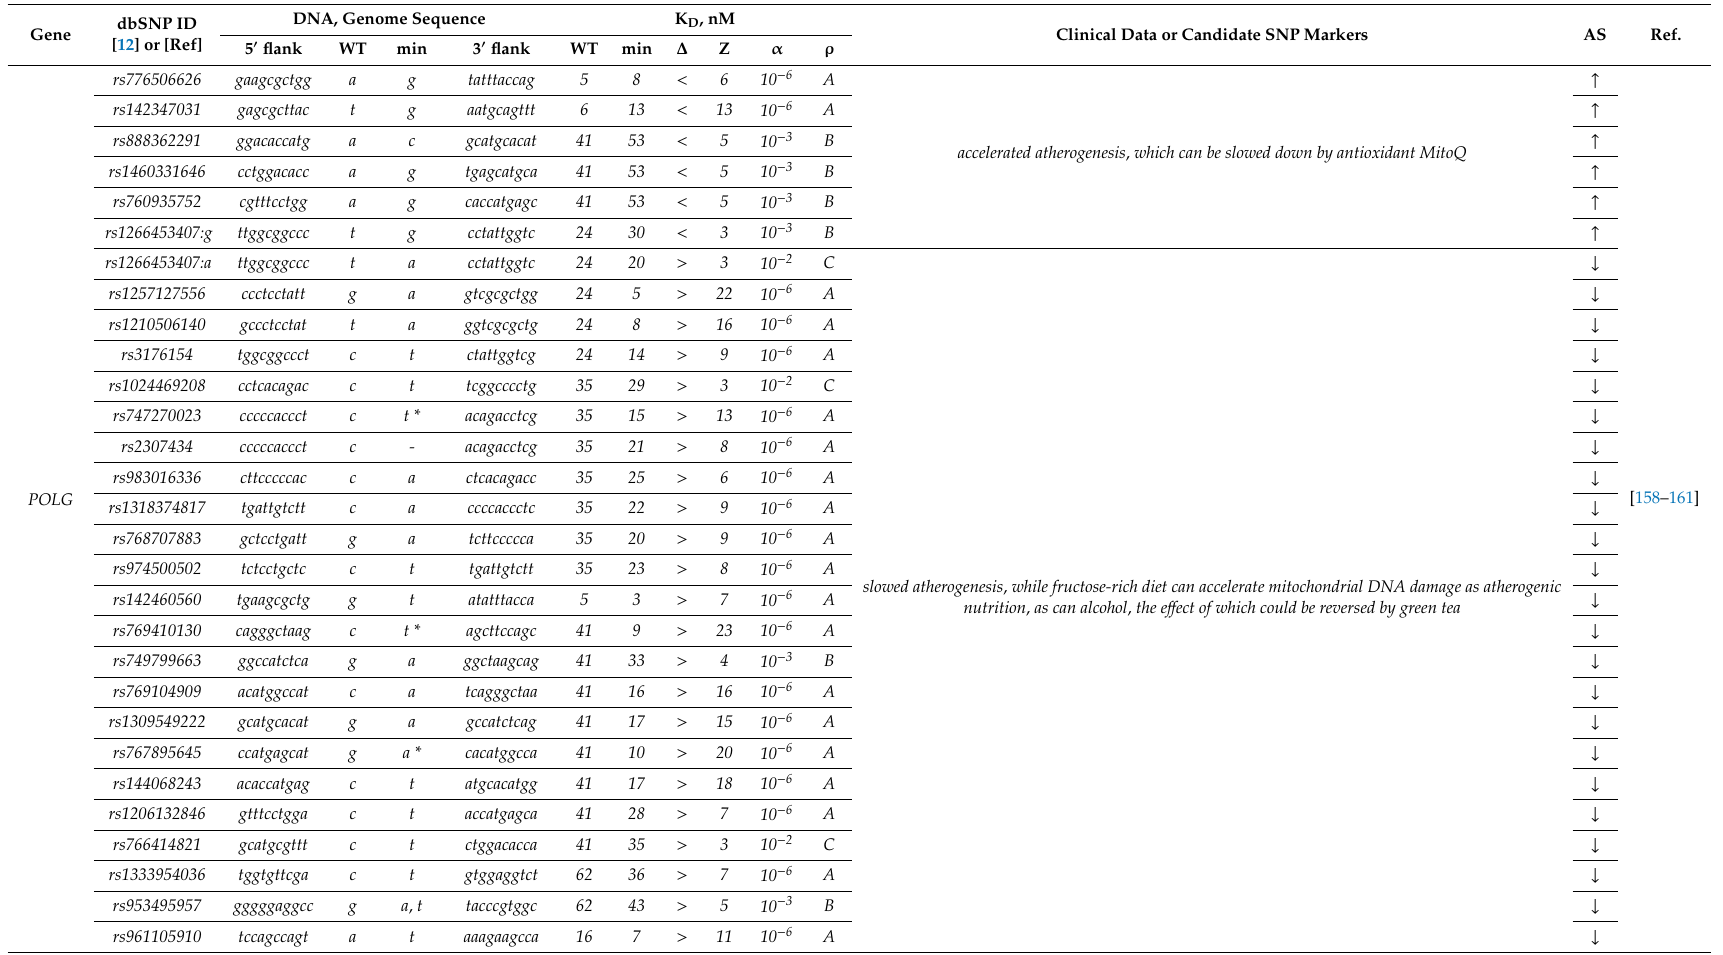
Table 8. Atherogenesis-related candidate SNP markers within promoters of the human protein-coding genes related to the maintenance of mitochondrial genome